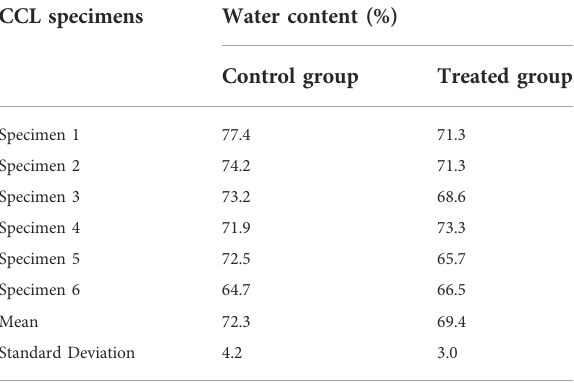
TABLE 2 The water content of the cranial cruciate ligaments (CCLs) in control (proteoglycans were not depleted) and treated (proteoglycans were depleted)